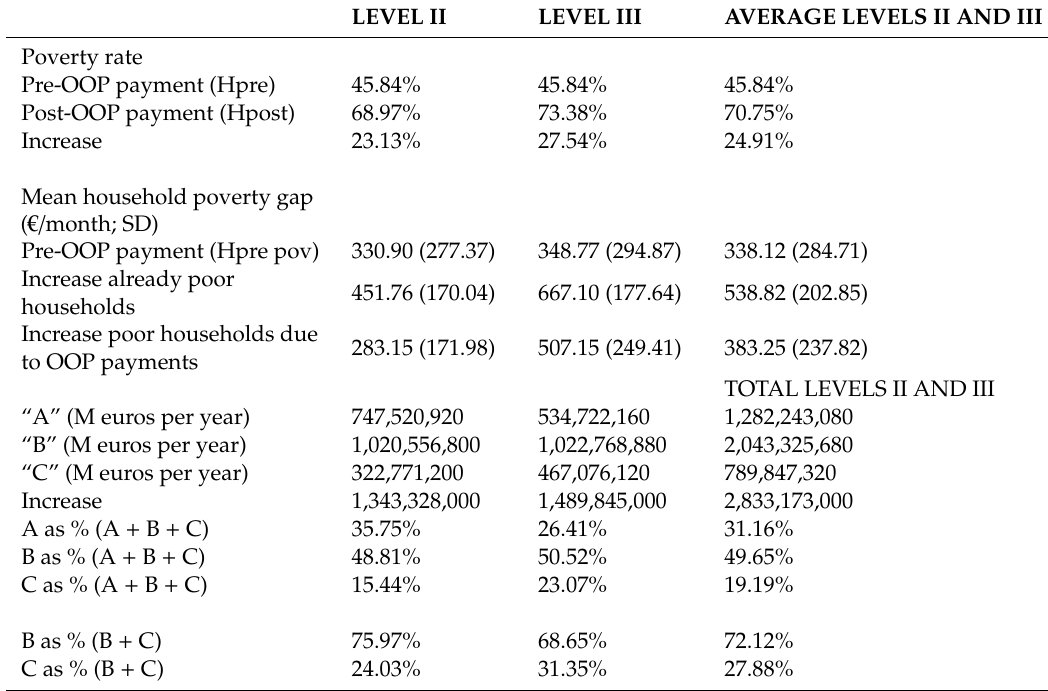
Table 6. Impoverishment rate of dependent care OOP payments by level. Scenario 1 (partial application, including levels II and III).